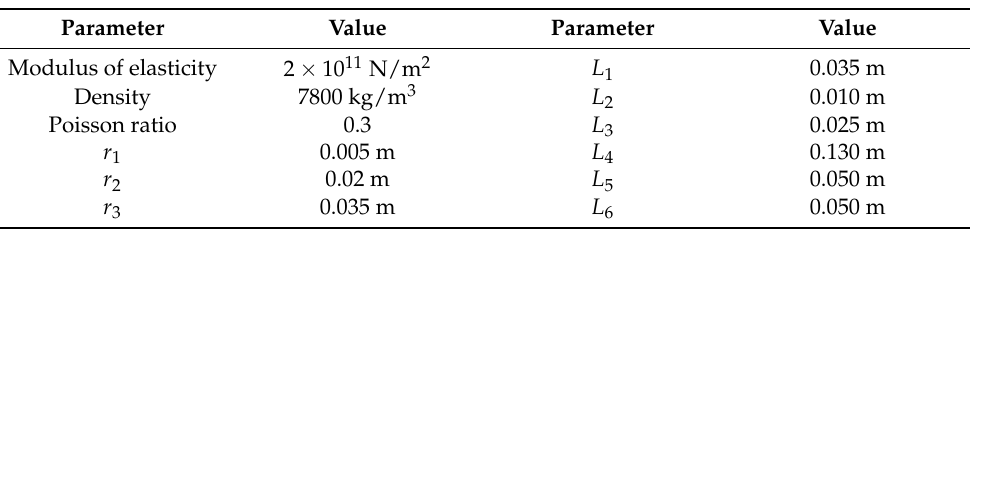
Table 1. Mechanical and geometrical properties of the rotor-bearing shaft.